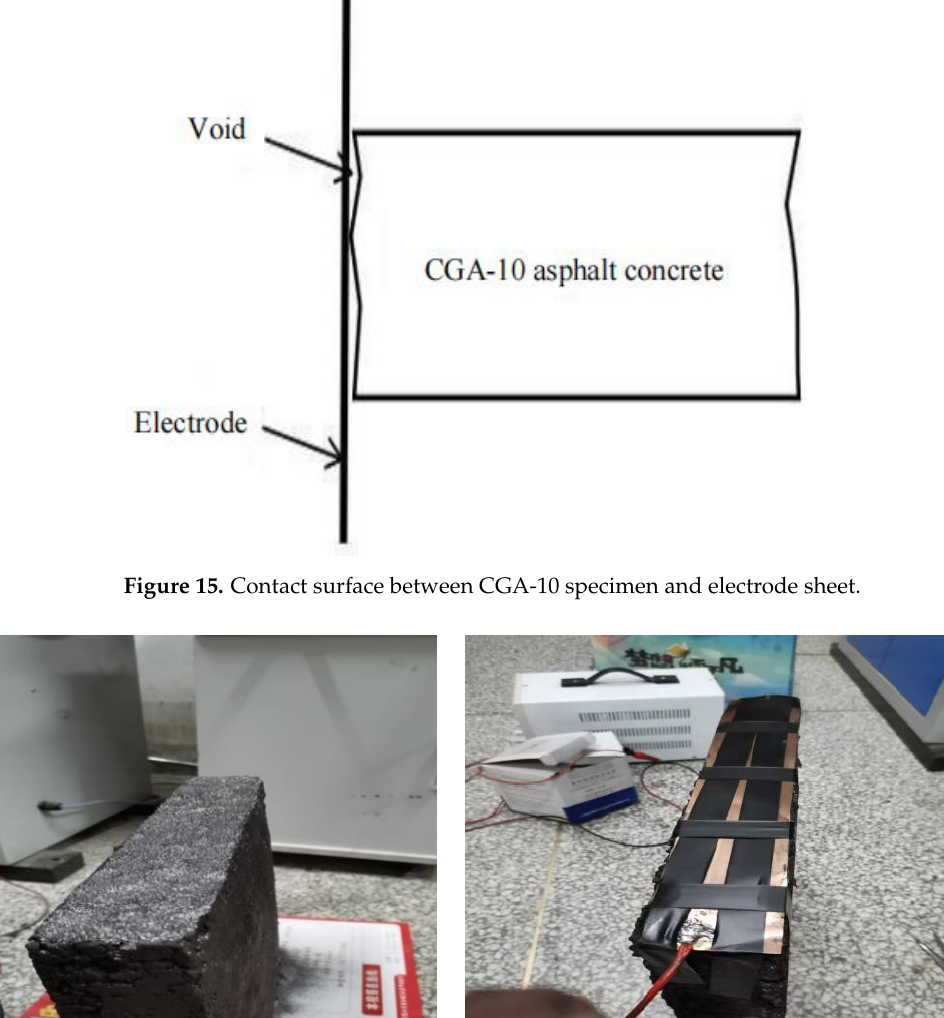
Figure 17. Diagram showing resistance variation trend of specimen.